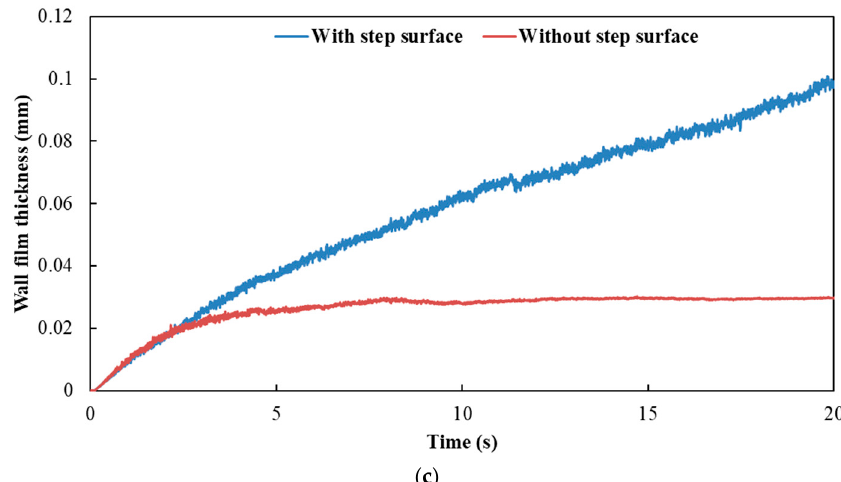
Figure 13. Influence of exhaust pipe with or without step surface on wall film thickness. ( a ) Case 1; ( b ) Case 2; ( c ) Case 3.